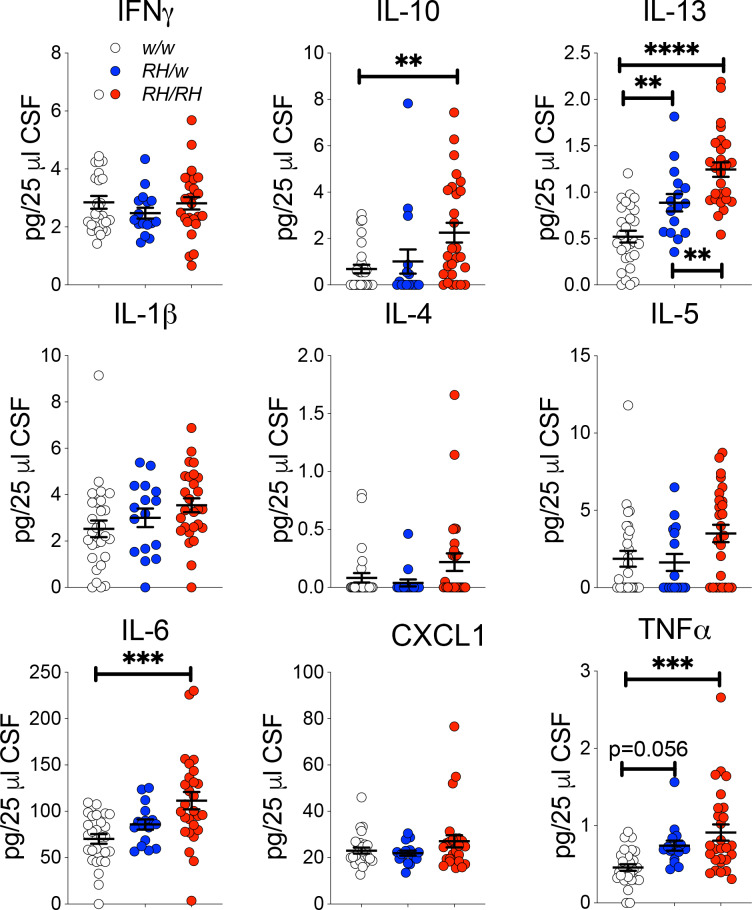
Levels of TNF-α and other pro-inflammatory cytokines are increased in the CSF of peri-adolescent Trem2R47H/R47H rats.Measurement of cytokines present in the CSF of 6–8 weeks old rats shows that IL-1β, IL-6, IL-10, IL-13 and TNF-α are significantly increased in Trem2R47H/R47H rats; IFN-δ, IL-1β, IL-4, IL-5 and CXCL1 are not. The same samples used for the experiments shown in Figure 1 were used here. Data are represented as mean ± SEM and were analyzed by ordinary one‐way ANOVA followed by post-hoc Tukey's multiple comparisons test when ANOVA showed significant differences [IFN-γ: F(2, 68)=0.7008, p=0.4997- IL-10: F(2, 68)=5.651, p=0.0054**; post-hoc Tukey's multiple comparisons test: w/w vs. RH/w, p=0.8335 (ns); w/w vs. RH/RH, p=0.0051**; RH/w vs. RH/RH, p=0.0779 (ns) - ANOVA summary of IL-13: F(2, 68)=26.21, p<0.0001****; post-hoc Tukey's multiple comparisons test: w/w vs. RH/w, p=0.0066**; w/w vs. RH/RH, p<0.0001****; RH/w vs. RH/RH, p=0.0090** - IL-1β: F(2, 68)=2.473, p=0.0919 - IL-4: F(2, 68)=2.504, p=0.0893 - IL-5: F(2, 68)=3.489, p=0.0361*; post-hoc Tukey's multiple comparisons test: w/w vs. RH/w, p=0.9545 (ns); w/w vs. RH/RH, p=0.069 (ns); RH/w vs. RH/RH, p=0.0753 (ns) - IL-6: F(2, 68)=9.016, p=0.0003***; post-hoc Tukey's multiple comparisons test: w/w vs. RH/w, p=0.361 (ns); w/w vs. RH/RH, p=0.0002***; RH/w vs. RH/RH, p=0.0707 (ns) – CXCL1: F(2, 68)=1.847, p=0.1656 - TNF-α: F(2, 68)=9.720, p=0.0002***; post-hoc Tukey's multiple comparisons test: w/w vs. RH/w, p=0.0565 (ns); w/w vs. RH/RH, p=0.0001***; RH/w vs. RH/RH, p=0.3403 (ns)].Figure 3—source data 1.Related to Figure 3.